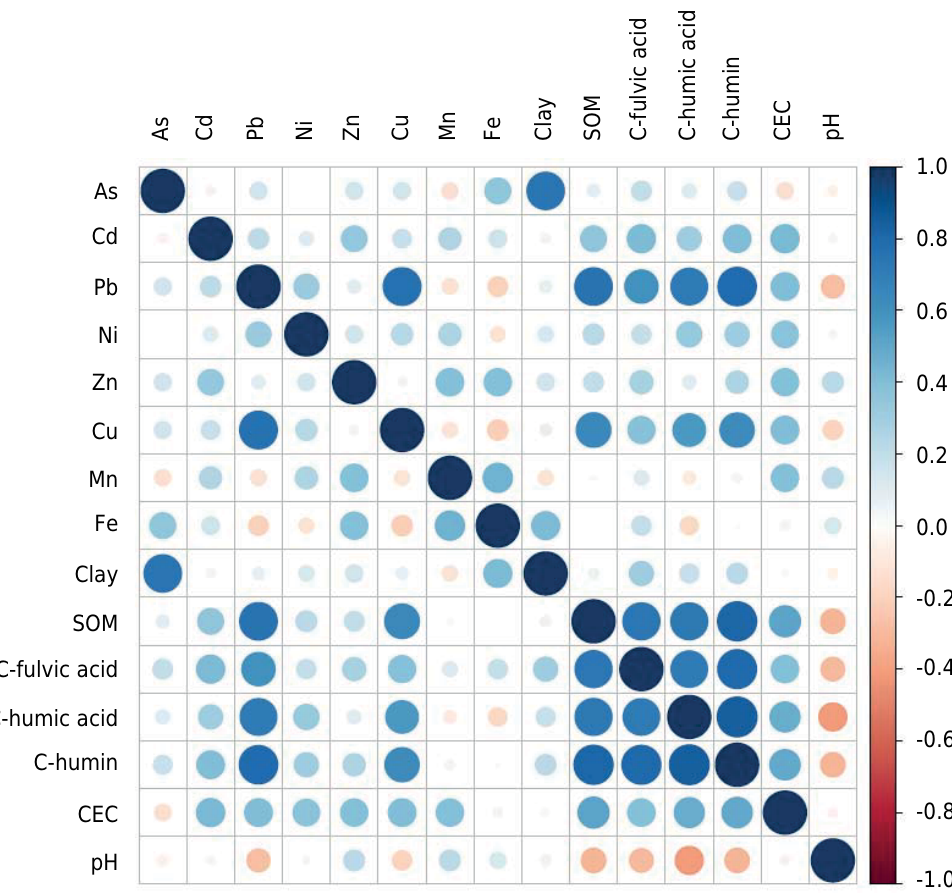
Figure 6. Correlation between As, Cd, Pb, Ni, Zn, Cu, Mn, and Fe contents and some properties of wetland soils from Triângulo Mineiro region,